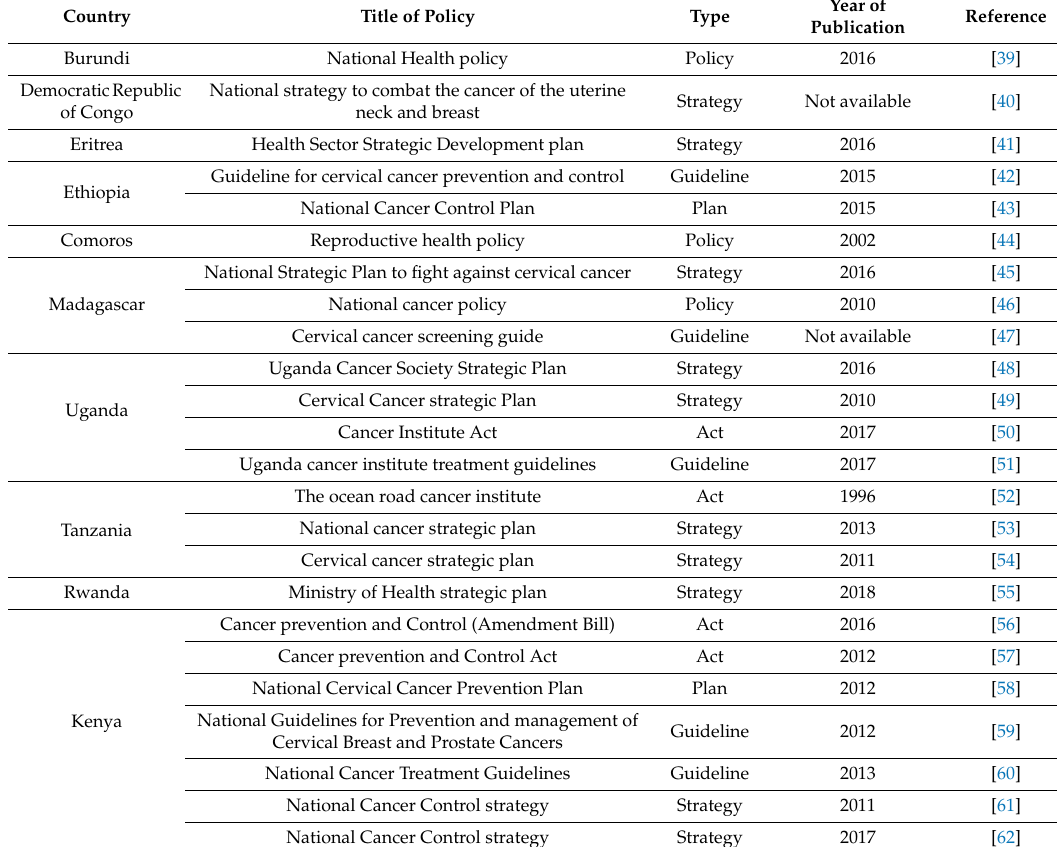
Table 1. List of policy documents by counties, title and year of publication.